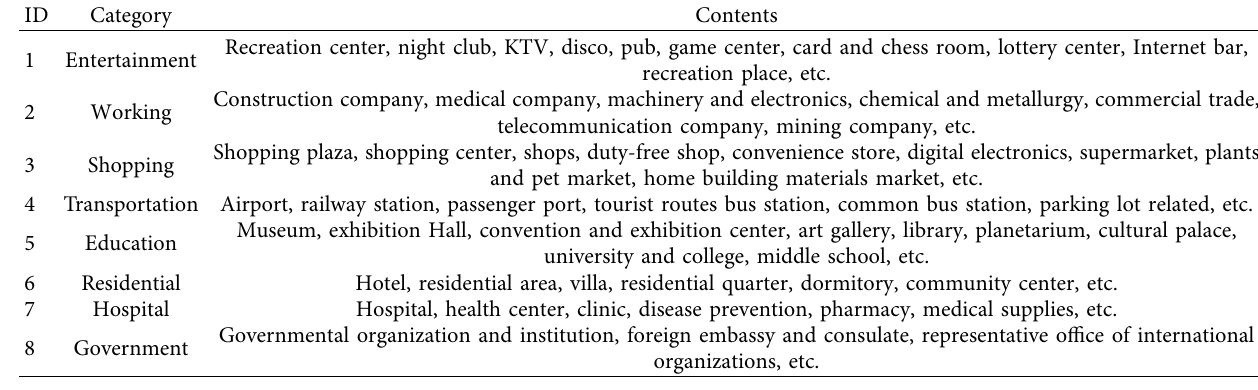
Figure 1: Overview of the Table 1: POI categories and contents.